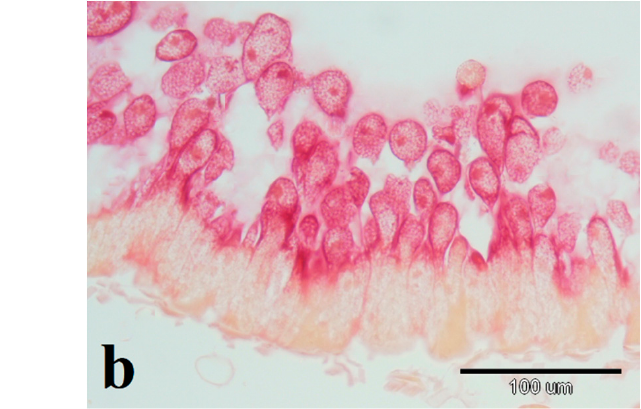
Figure 9. Leucine aminopeptidase enzymatic activity in mid-gut enterocytes of adult honeybee originated from colony previously fed sugar syrup supplemented with BPC 157 ( a ), and untreated colony fed only sugar syrup ( b ); magnification ×40.